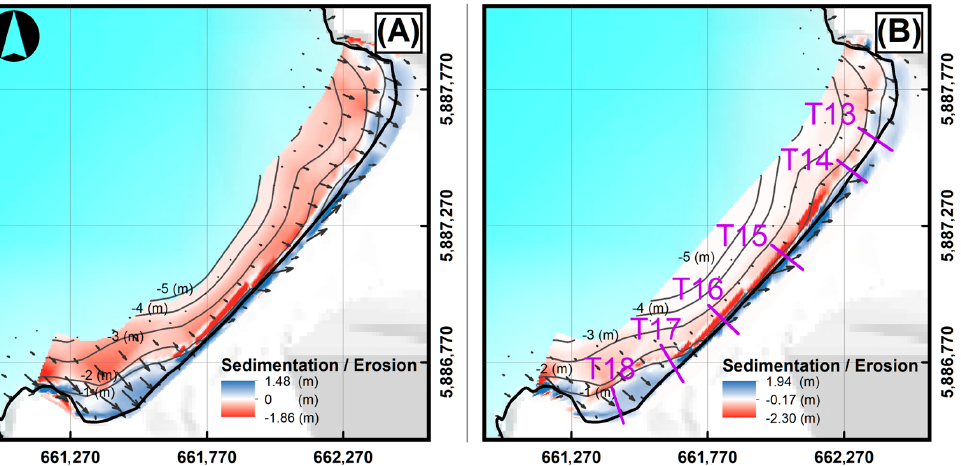
Figure 14. Morphological changes in Chivilingo during: ( A ) winter and ( B ) summer, as in Figure 13. T13–T18 are control transects at Chivilingo beach.